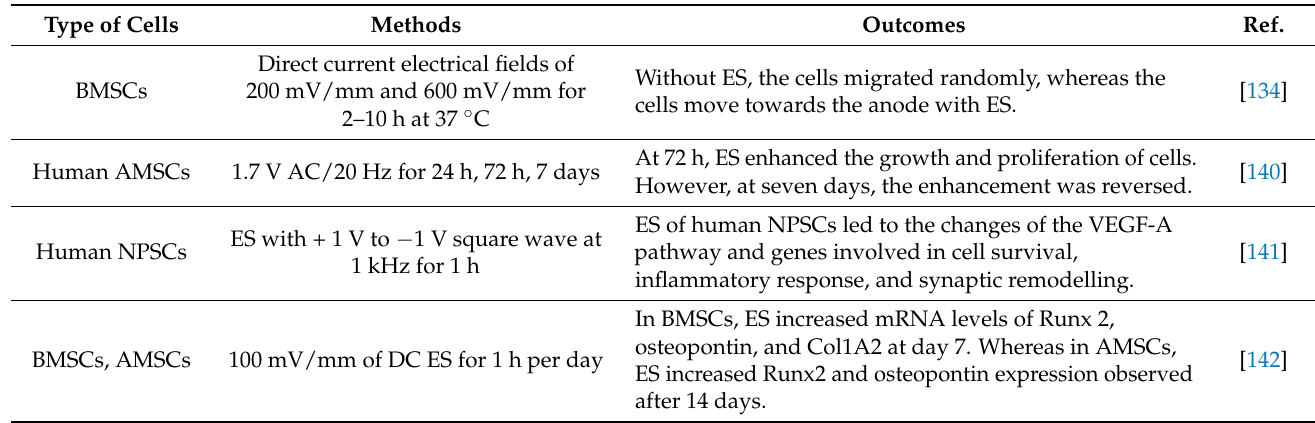
Table 6. Electrical stimulation for SCs